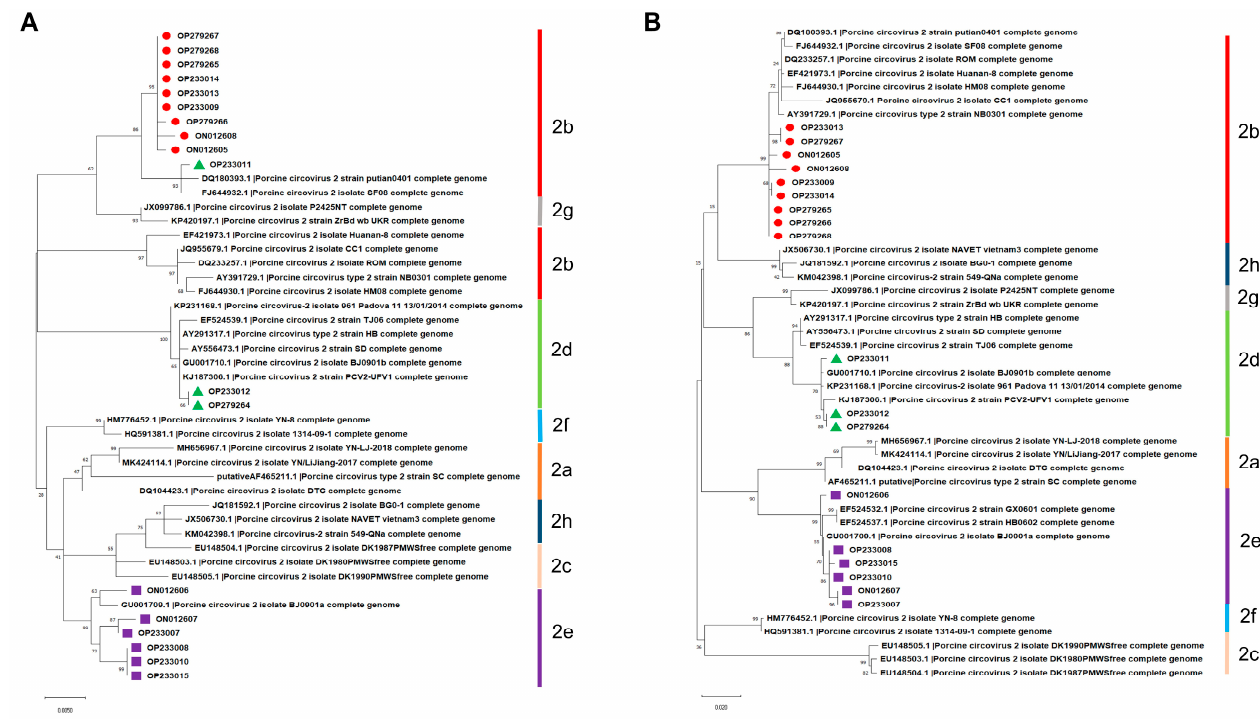
Figure 2. Phylogenetic trees constructed based on the nucleotide sequences of PCV2 ORF1 and ORF2. ( A ) ORF1. ( B ) ORF2.